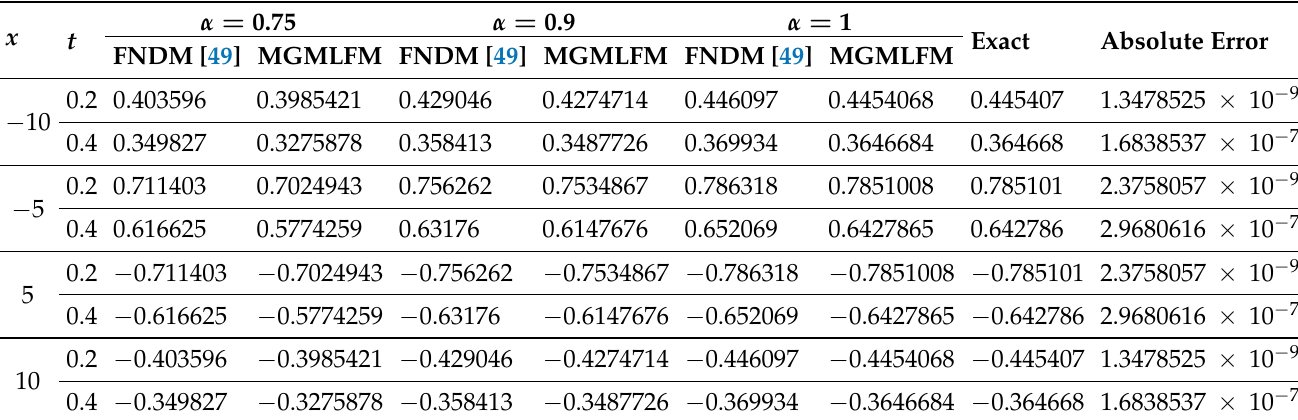
Table 3. Values of approximate solutions obtained by MGMLFM, FNDM, exact solution, and absolute errors of U ( x , t ) and V ( x , t ) for system (3) with various values of α , t , x and y = 0.4.